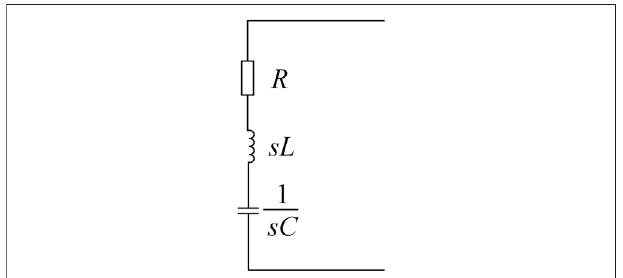
FIGURE 3 | Zero-state response equivalent circuit model of MMC in frequency domain.